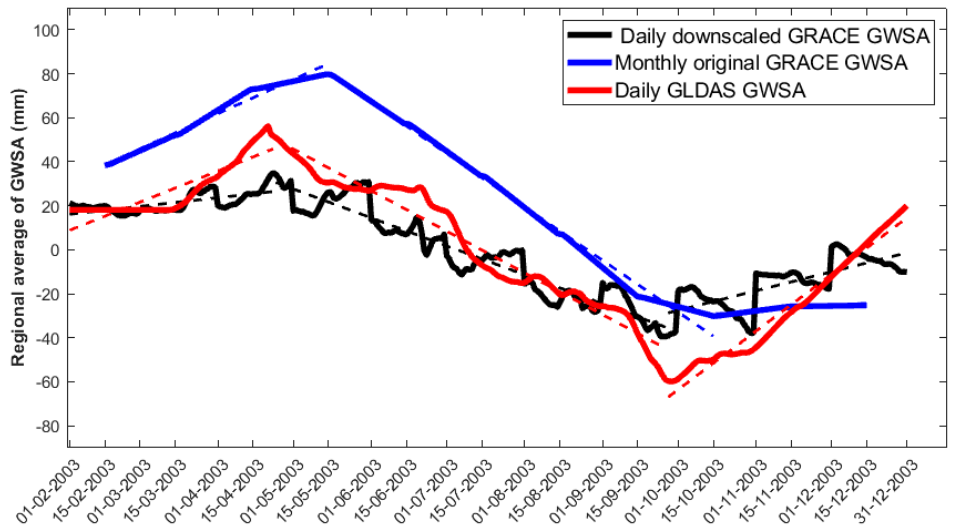
Figure 13. Daily time series of downscaled GRACE GWSA (black colour), vs. monthly time- series of original GRACE GWSA before downscaling (blue colour), across study area from February to December 2003 [mm]. Dash lines show the seasonal trend.